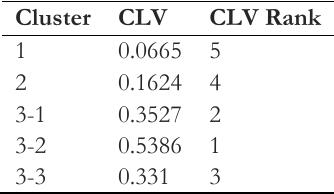
Table 11. Calculation of CLV cluster